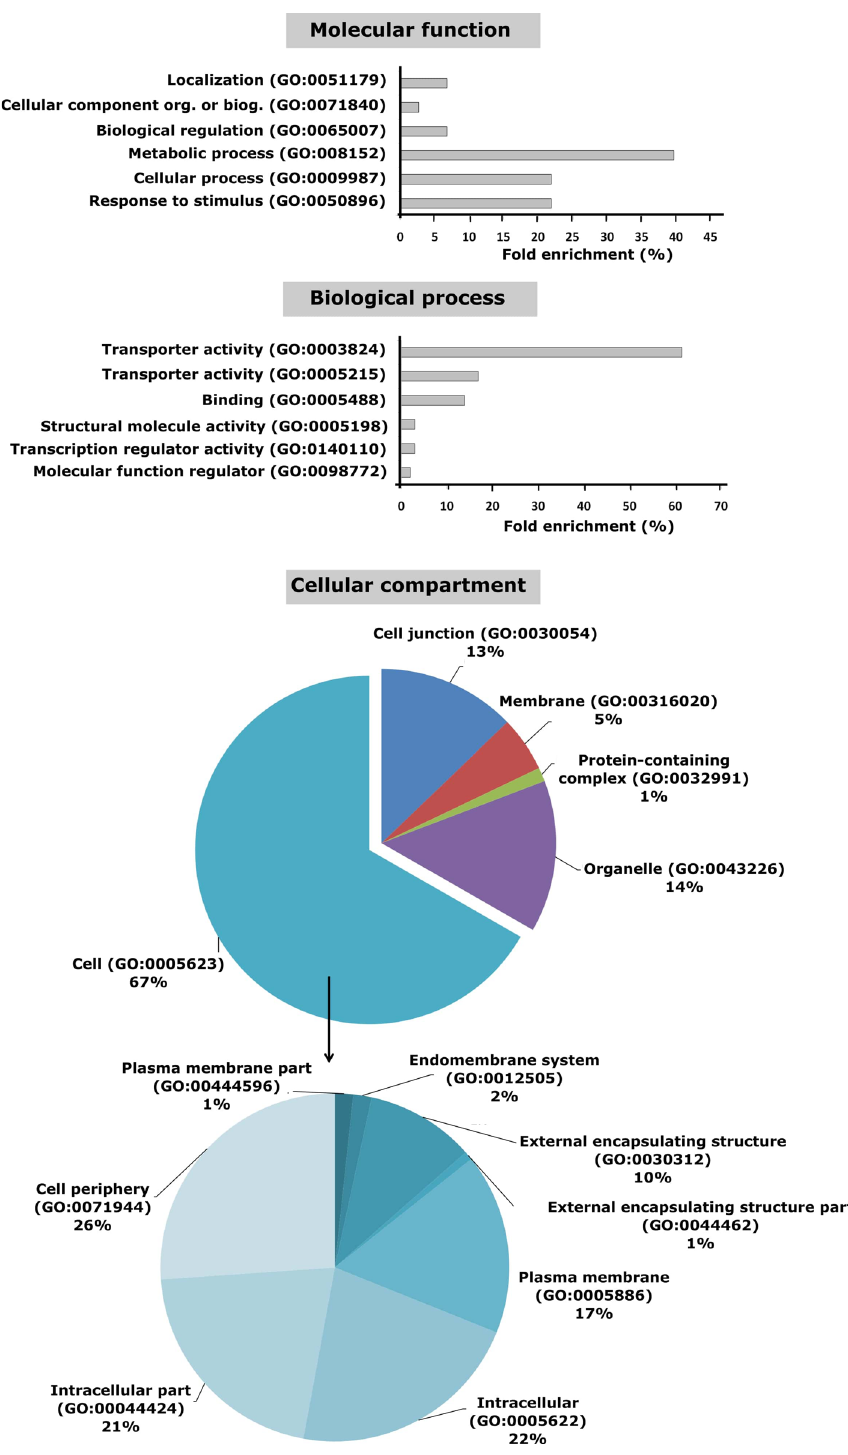
Figure 3. GO terms associated with transcriptome modulation of tomato roots in response to hypoxia and SNP-treatment. Enriched GO terms ( P adj < 0.05), describing molecular function, biological process and cellular compartment. The regulated genes in all samples were analyzed for enriched GO terms using online tool PANTHER 14.0 and Solanum lycopersicum as a reference organism. The bars represent all significantly enriched GO terms associated with regulated genes in response to hypoxia and